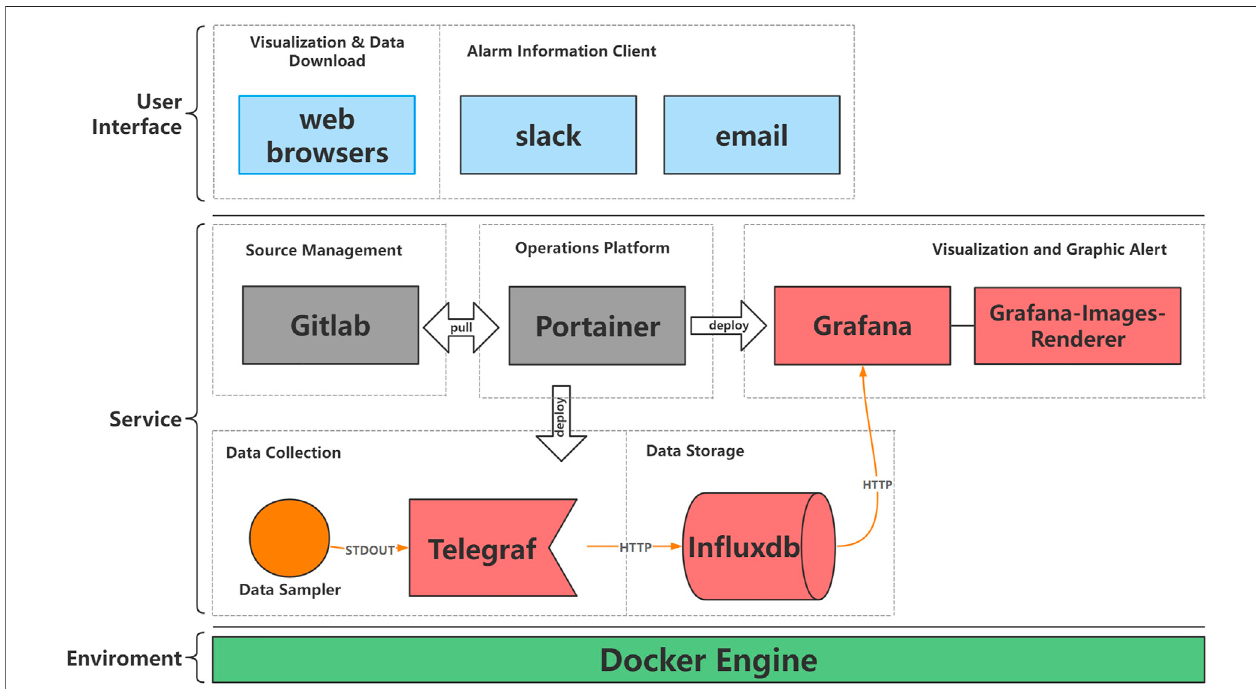
FIGURE 2 | Figure shows that the architecture of the TAEWS is divided into three parts: environment, services, and user interface. All services of the TAEWS are deployedontheDockerEngine.ServicesmainlyincludeDataSampler,Telegraf,In fl uxdb,Grafana,Grafana-Images-Renderer,Portainer,andGitLab.DataSamplerand Telegraf are used for data collection, In fl uxdb for the time-series database, Portainer for container deployment, GitLab for source code management, Grafana and GrafanaRenderforvisualizationandgraphicalert.Userinterfacesincludewebbrowsers,Slack,andemail.Userscanaccessvisualizationpagesthroughbrowsers and push alerts through email, Slack,